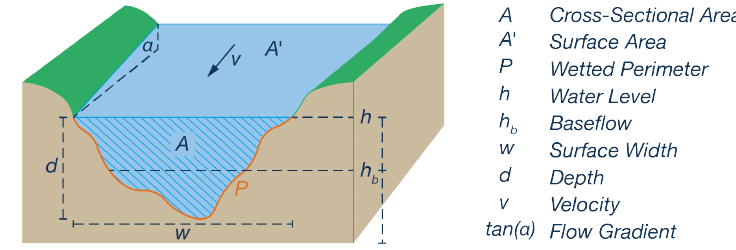
Figure 3. At-a-station hydrographic